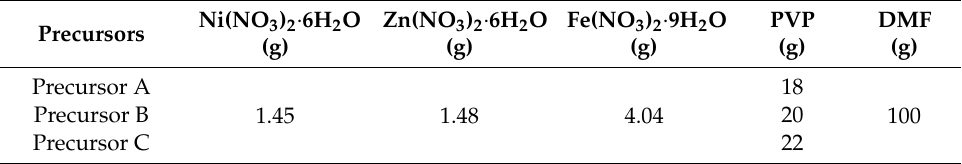
Table 1. The composition and content of the precursor solution. PVP: Polyvinyl pyrrolidone; DMF: